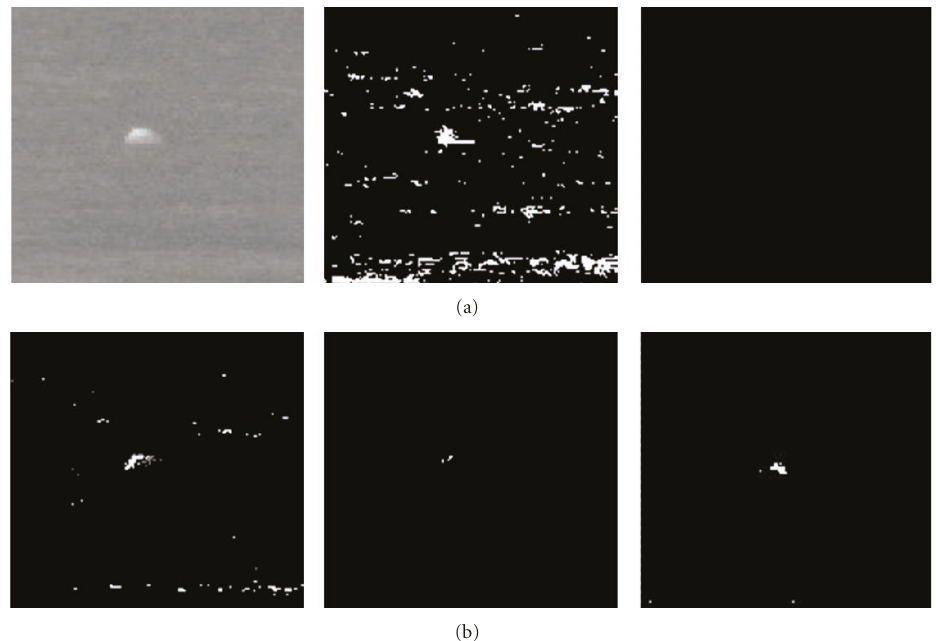
Figure 6: MW03 sequence in the 3–5 μ m band. From left to right, (a): original, mean, gmm. (b): EGMM, ViBe, behaviour subtraction.